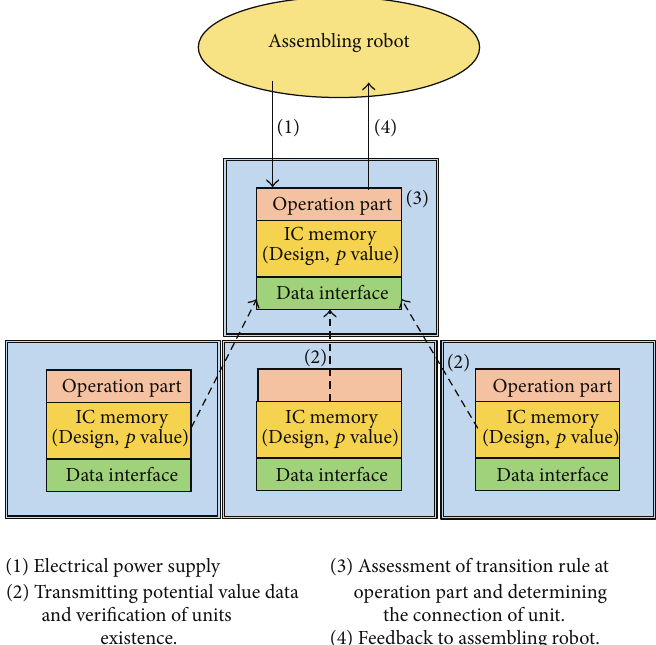
Figure 12: Example of the construction procedure of the structural units. Units need simple circuits, small memory capacity, and minimum communication functions. Such circuits may be made by IC tags or nonvolatile